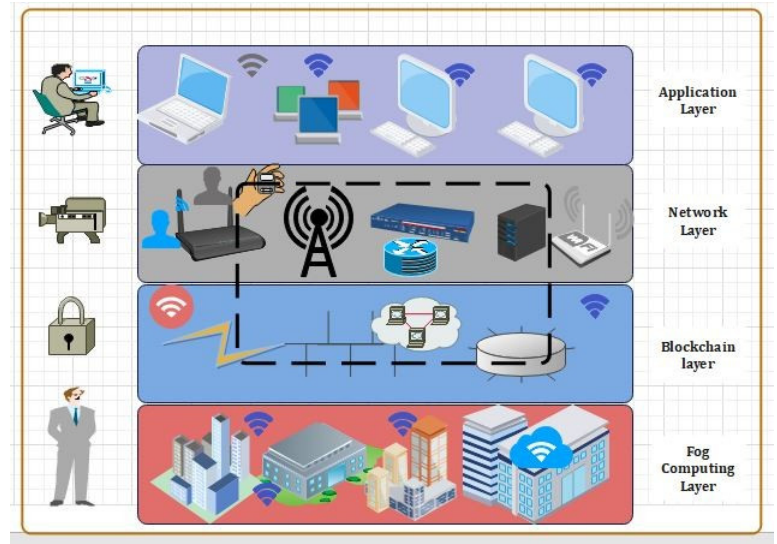
Figure 3. The proposed secure searchable encryption system and the system layers.